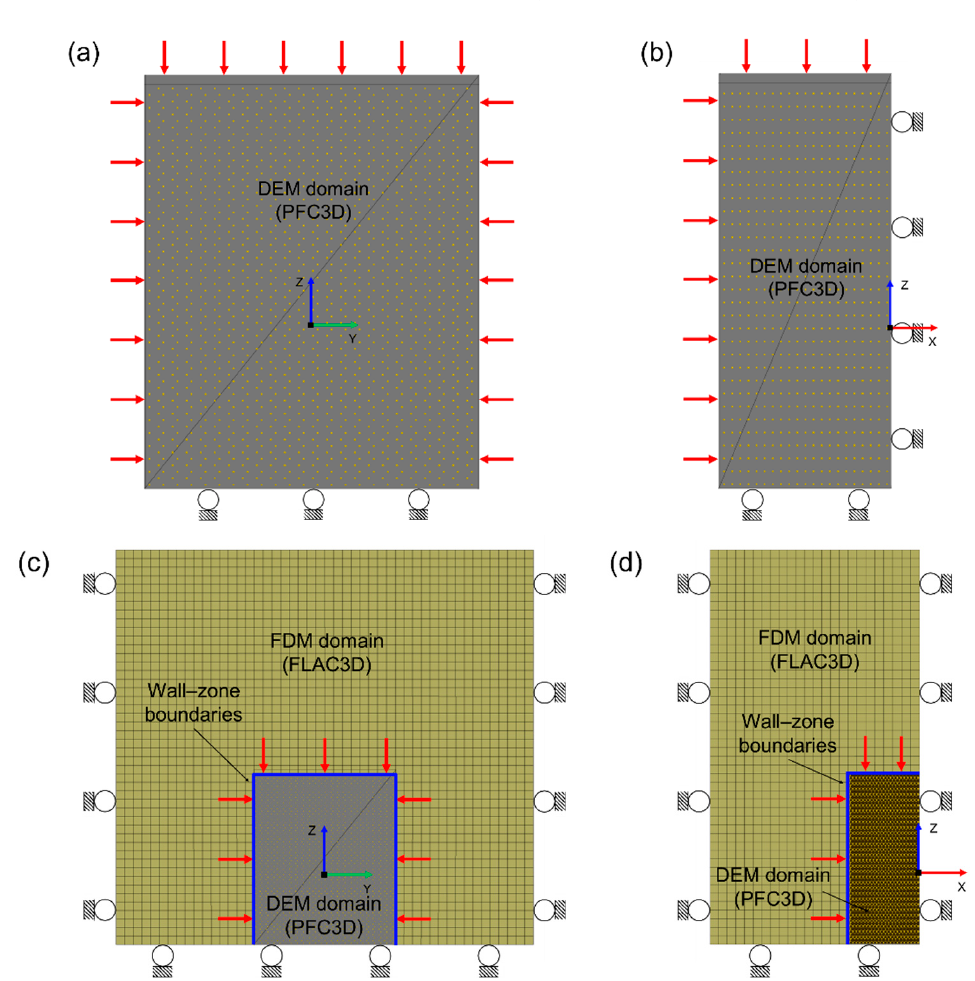
Figure 6. Ground formation modeling procedure: ( a ) wall compaction (front view); ( b ) wall compaction (side view); ( c ) wall–zone compaction (front view); ( d ) wall–zone compaction (sectional view). Table 5. Summary of input parameters for ground formation.